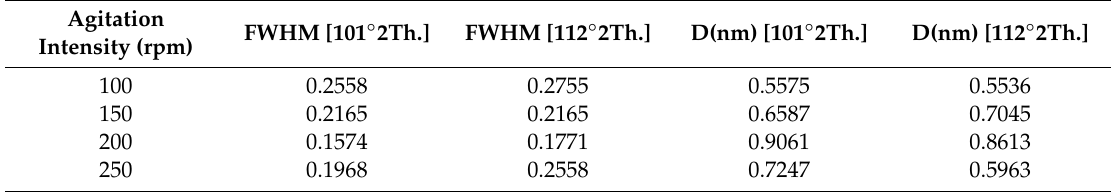
Table 2. XRD information of the NH 4 ReO 4 recrystallization particles at di ff erent stirring speeds.